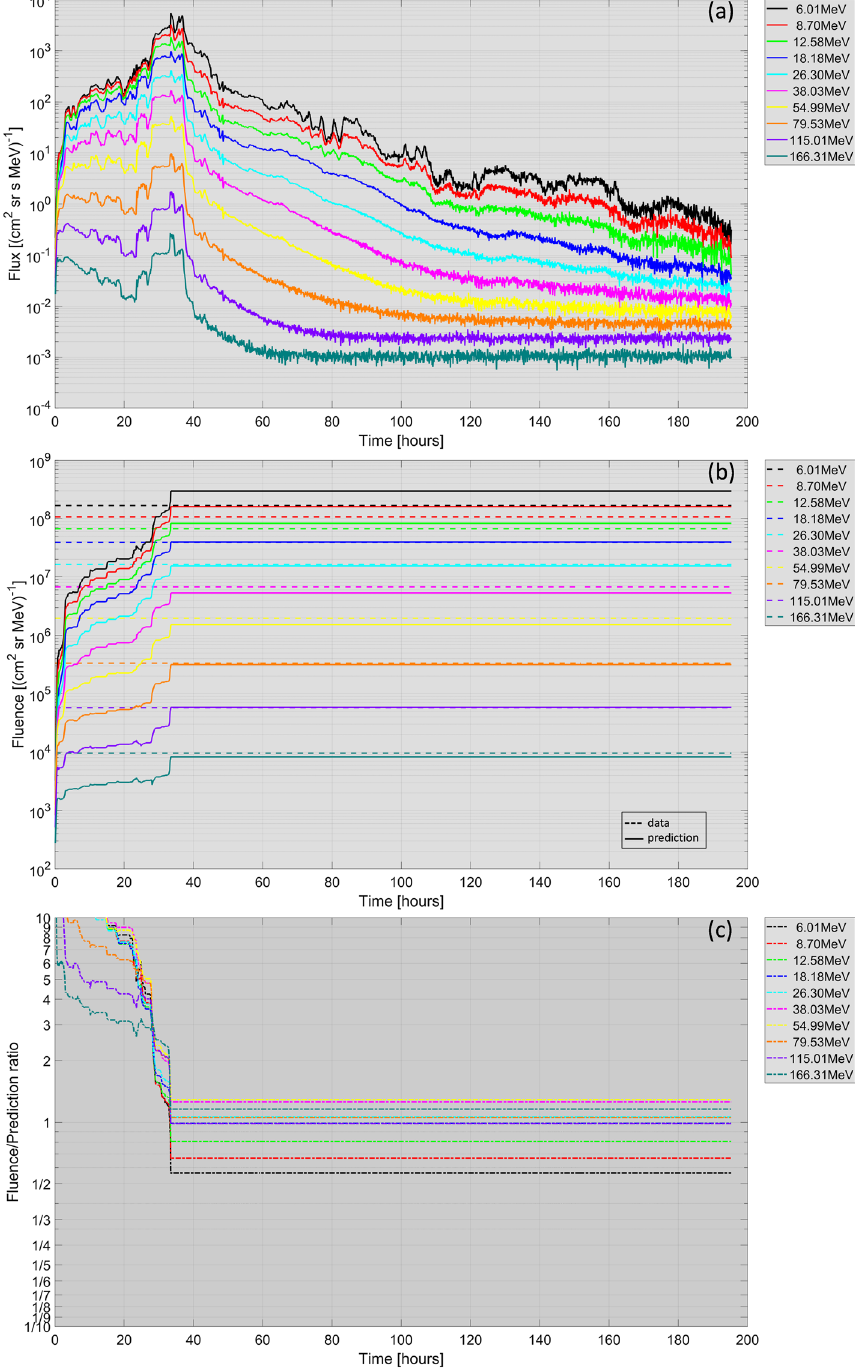
Fig. 13. (a) Flux time-series of SPE, (b) Fluence prediction time-series are in solid lines and SPE data Fluences are shown in dashed lines for comparison and (c) time-series of Fluence over prediction